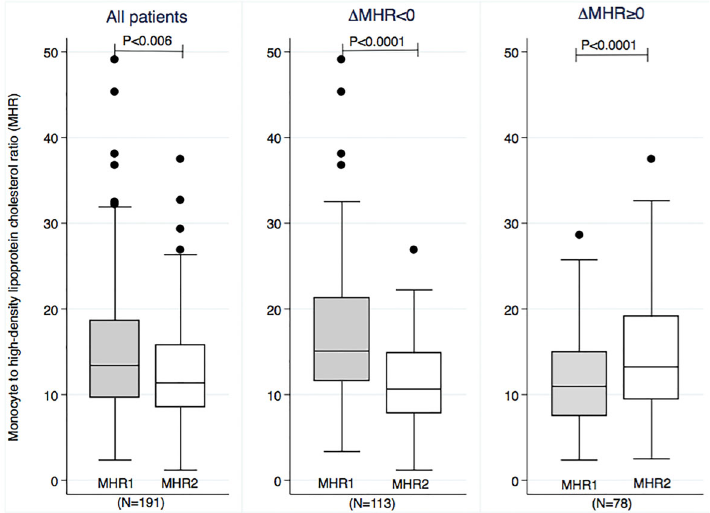
Figure 2. Box-plot graph comparing the MHR1 and MHR2 in all patients included in this study (left panel), in the patients whose MHR decreased over time ( D MHR o 0) (middle panel), and in the patients whose MHR increased over time ( D MHR X 0) (right panel). Data are reported as medians and interquartile ranges; Wilcoxon matched-pair signed rank test. MHR1: monocyte to high-density lipoprotein cholesterol ratio at hospital admission; MHR2: monocyte to high-density lipoprotein cholesterol ratio at fi rst outpatient evaluation; D MHR: MHR2 – MHR1.